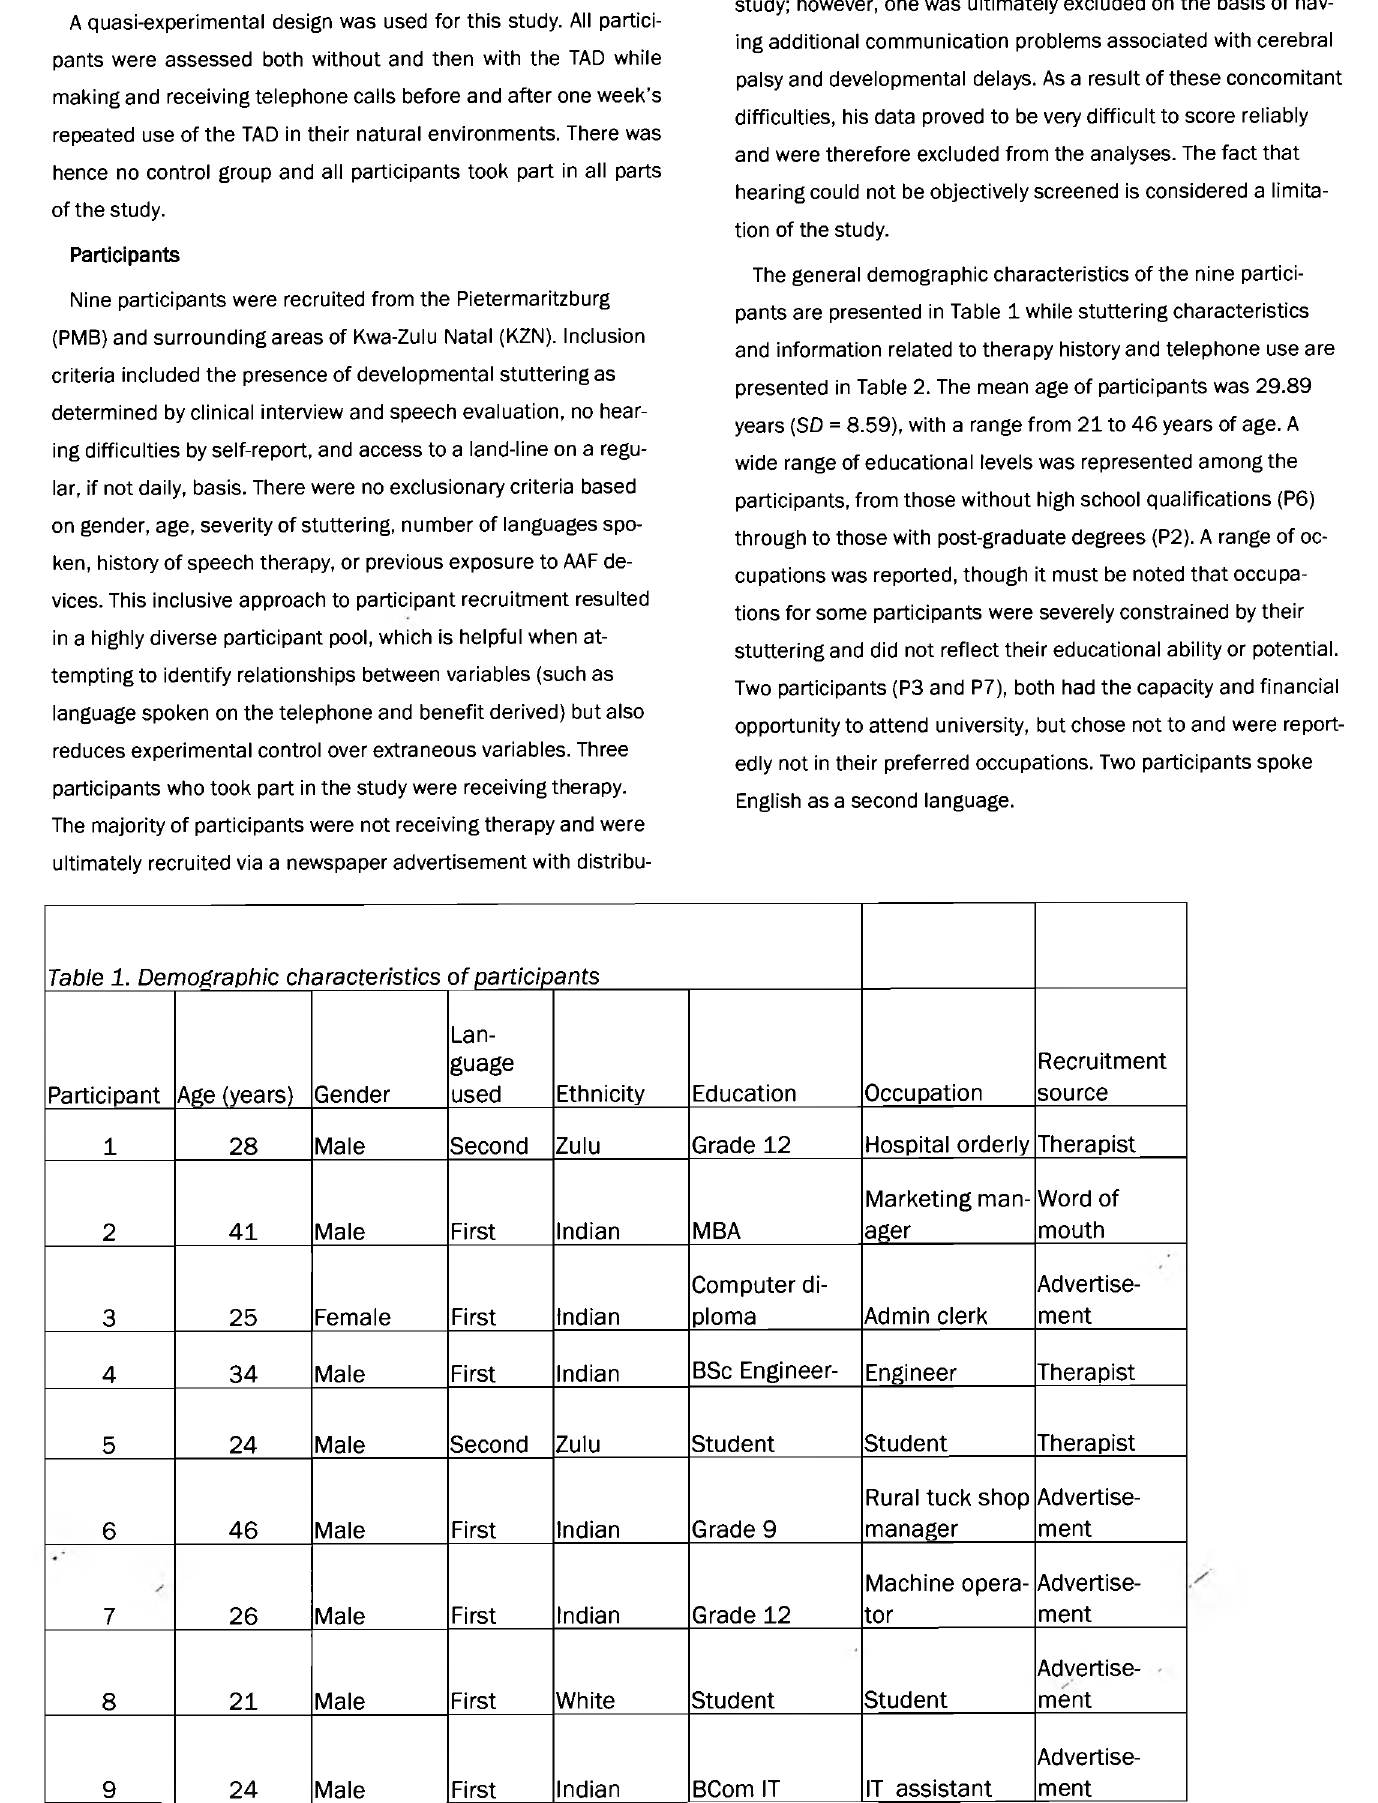
Table 1. Demographic characteristics of